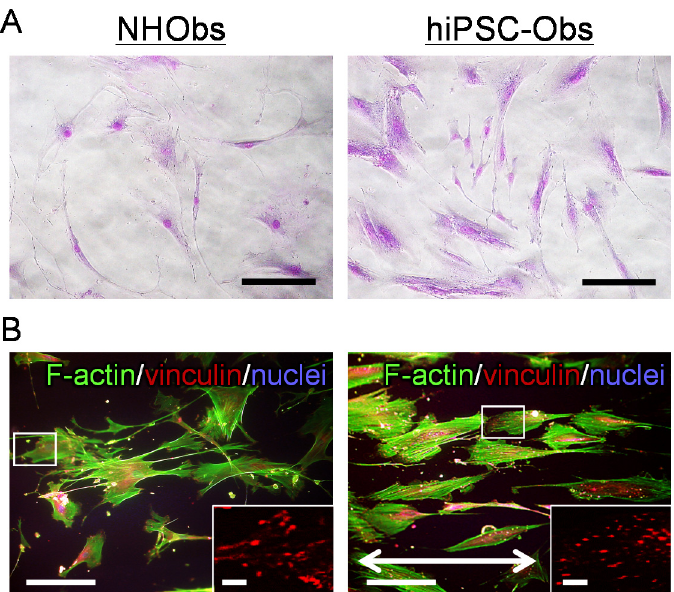
Figure 3. Observation of the cell behavior of human-induced pluripotent stem cell-derived osteoblasts (hiPSC-Obs) on a bone-mimetic collagen scaffold. ( A ) Non-uniform shape and random orientation of Giemsa-stained hiPSC-Obs and normal human osteoblasts (NHObs) on a cell culture plate. Scale bars: 100 µm. ( B ) Morphological changes of cells and focal adhesions (FAs) in hiPSC-Obs and NHObs on a collagen scaffold. The bidirectional arrows indicate the axis of collagen orientation on the scaffold. Green, F-actin; red, vinculin; blue, nuclei. Scale bars: 100 µm. The insets show magnified images of FAs of single cells. Scale bars: 10 µm.